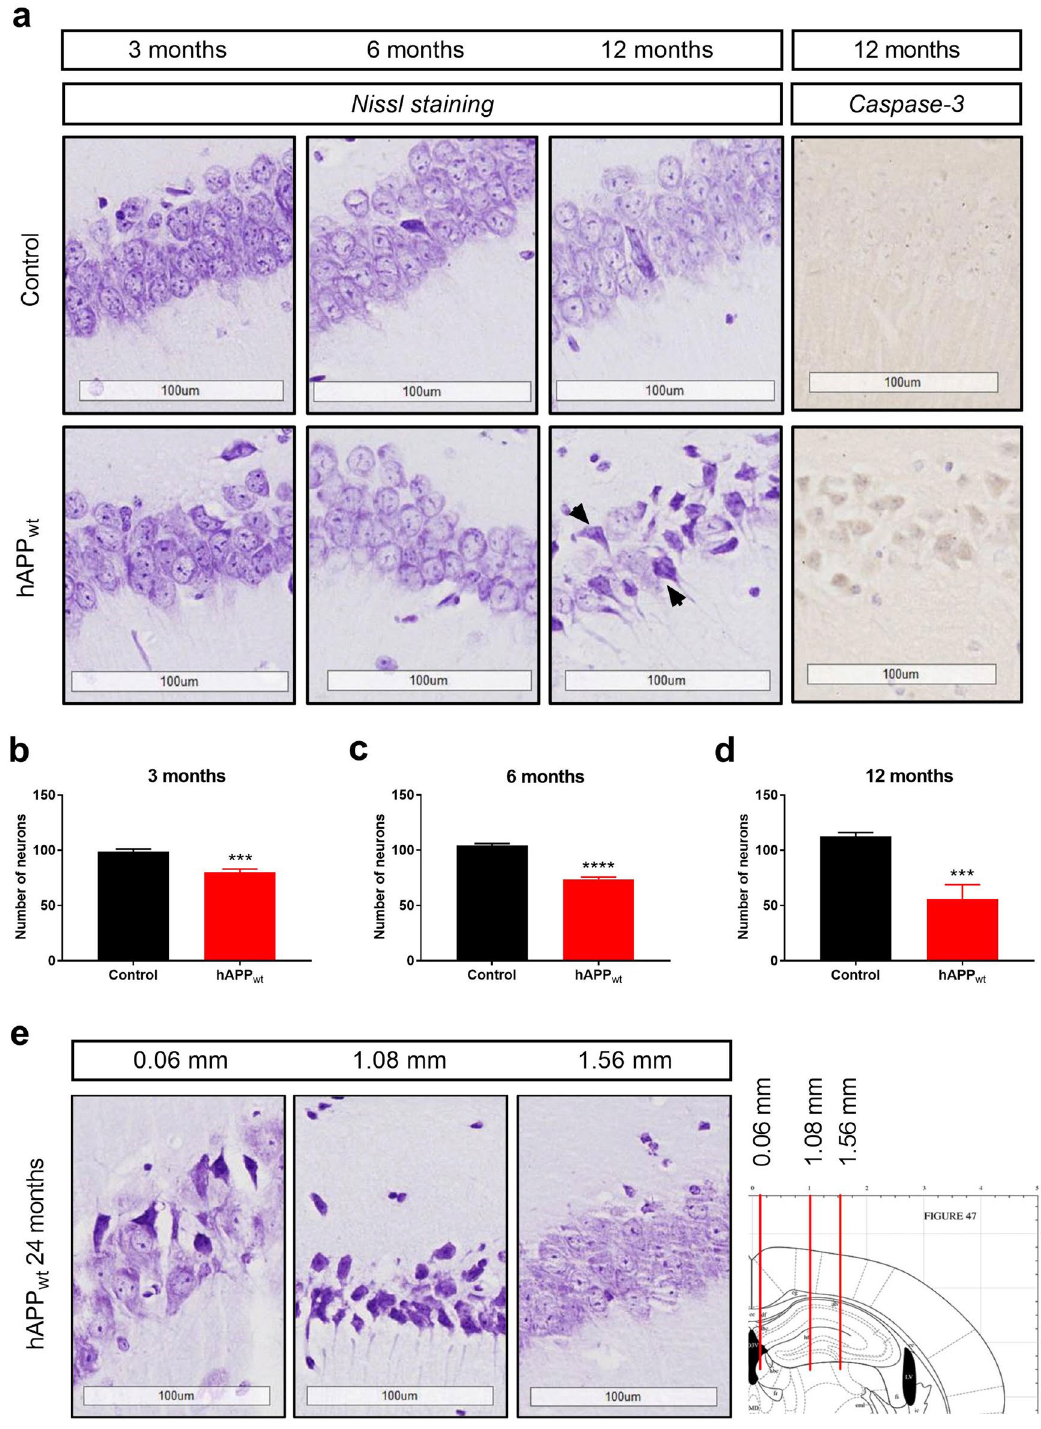
Figure 4. Morphological changes in the CA1 hippocampal region in male hAPP wt and age-matched control animals at 3–24 months of age. ( a ) Comparison of Nissl stained sagittal brain sections of the hippocampal CA1 area between hAPP wt and age-matched control littermates, starting at 3 months and progressing to 12 months of age. Arrows mark the presence of dark Nissl stained neurons in hAPP wt mice at 12 months of age, which is a sign of neuronal death. Neuronal degeneration and death were confirmed by caspase-3 staining in 12 month old hAPP wt animals. ( b–d ) Quantification of surviving neurons in the CA1 area of 3, 6, and 12 month old hAPP wt animals and age matched littermates. Neurons with round and palely stained nuclei were considered as viable, while shrunken and dark stained cells were considered as dead. Data are expressed as the number of surviving neurons per analyzed CA1 section (300 μm × 300 μm) in each age group for hAPP wt (n = 8) and control (n = 8) mice. ( e ) Nissl stained sagittal brain sections of the hippocampal CA1 area in 24 month old hAPP wt mice reveal a lateral progression of neuronal degeneration, which is evident by the presence of dark Nissl stained neurons. Sections were taken later at 0.06 mm, 1.08 mm, and 1.56 mm; values are means ± SEM; ***P ≤ 0.001, ****P ≤ 0.0001, two-tailed unpaired